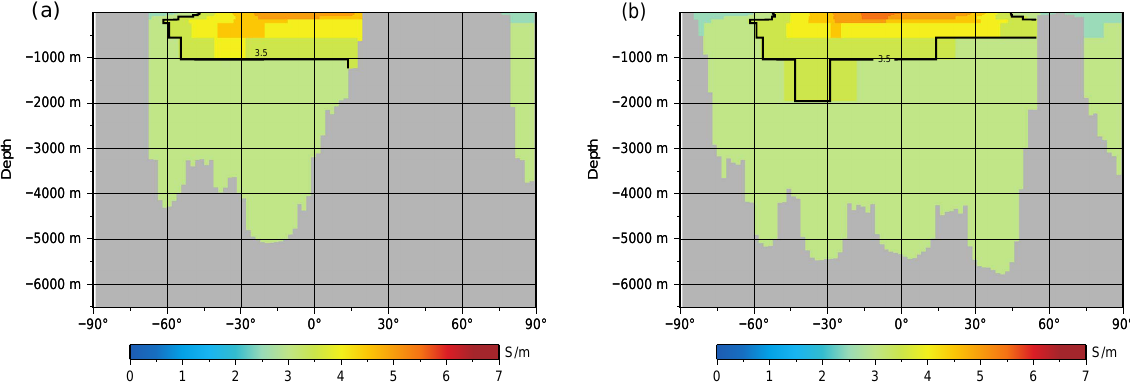
Figure 2. Meridional sections of seawater conductivity distribution at 90 ◦ E (a) and 182 ◦ E (b) . Ocean depth is given in metres. The black contour line indicates the mean conductivity of 3.5Sm − 1 .